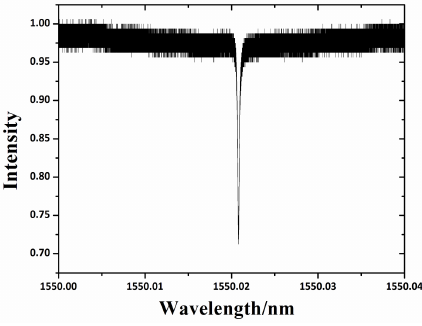
Figure 10. Output spectrum of the proposed single-ended microbubble-based WGM resonator.